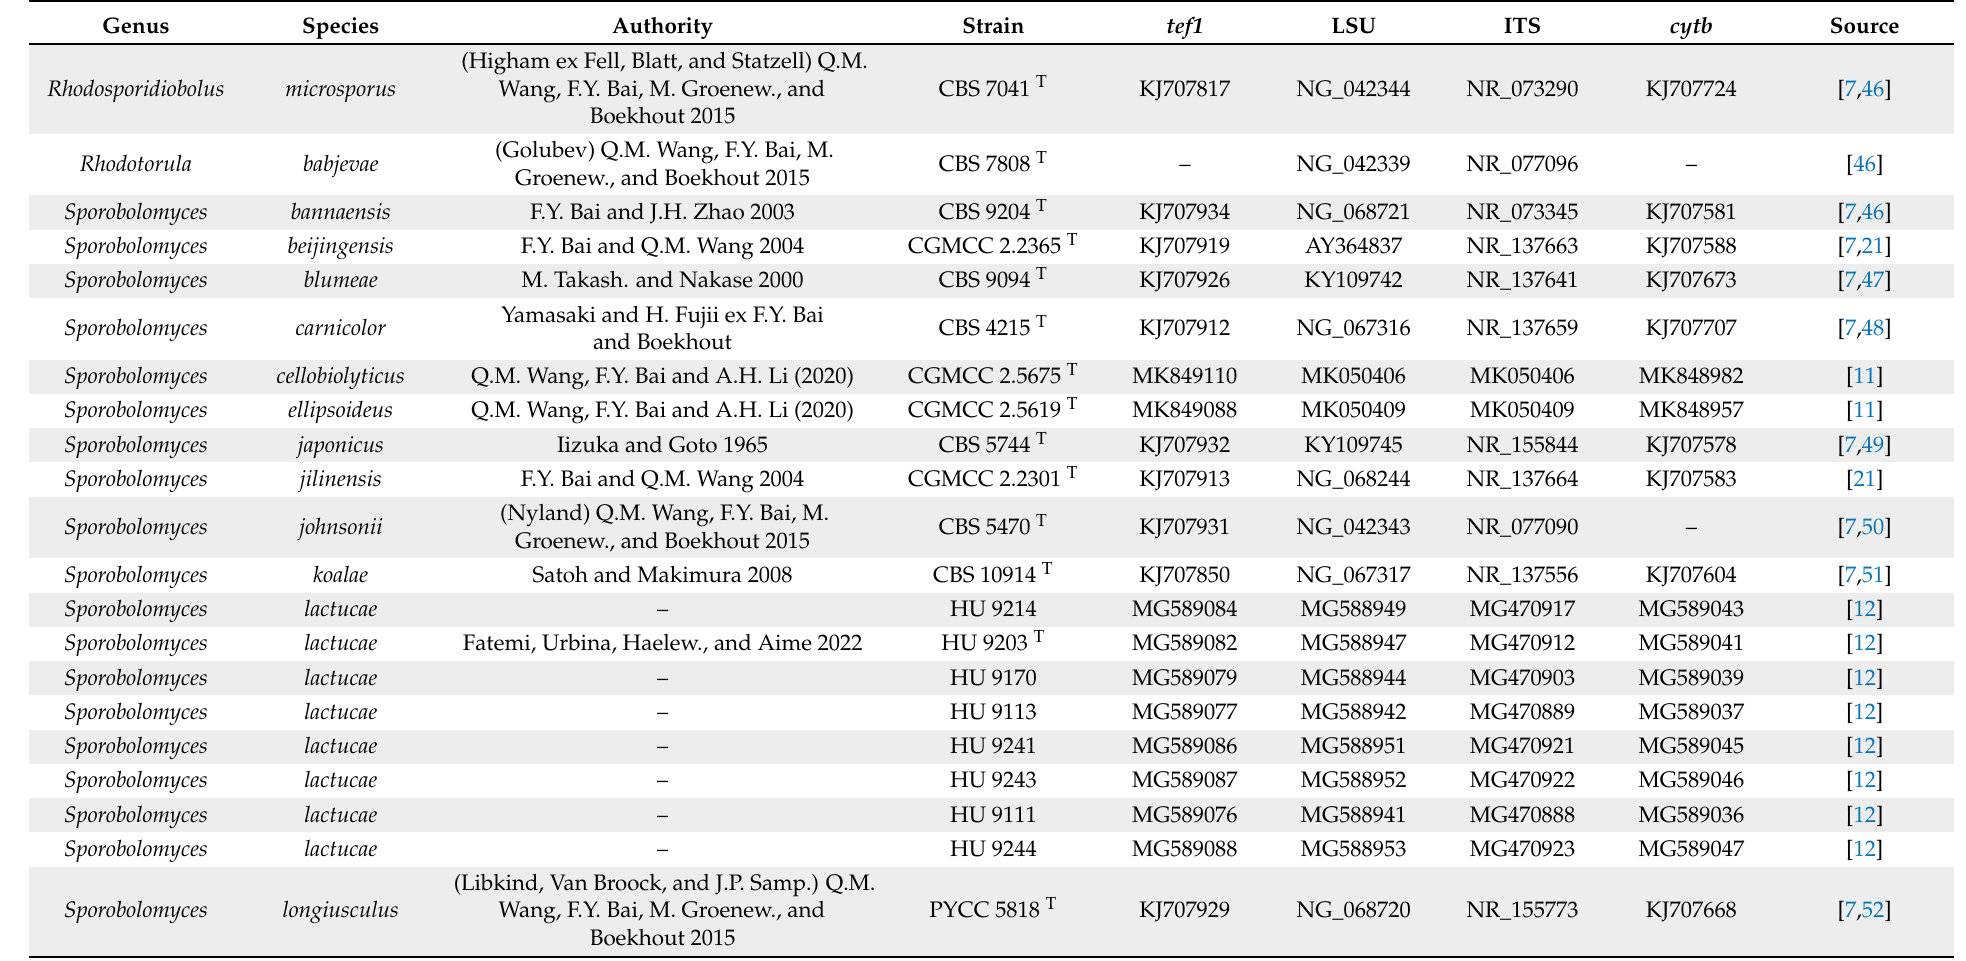
Table 1. Isolates used in the phylogenetic reconstruction of Sporobolomyces s.s. Four loci were selected in this analysis: cytb , tef1 , LSU D1/D2 domain, and ITS. Type strains are designated with T